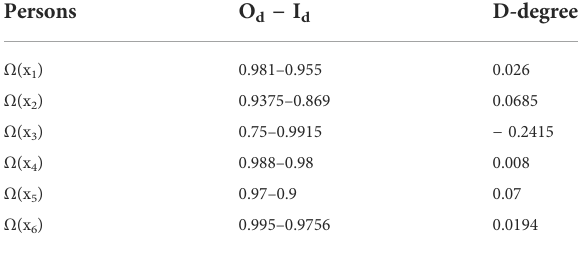
TABLE 13 Domination degree of every person.